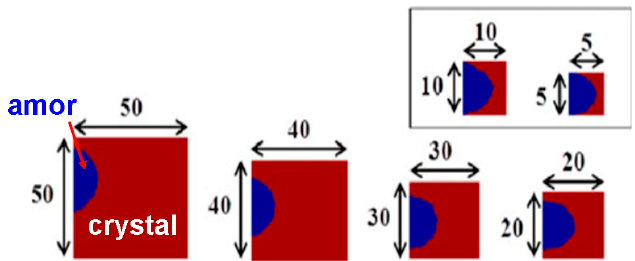
Figure 20. The resulting amorphous bits (blue region) embedded inside the surrounding crystalline background (brown red region) with respect to the thickness of the GST layer. The shape of the amorphous bit changes from a rounded shape for larger GST dimensions to ellipsoidal for smaller dimensions. Reproduced with permission from [51]. Copyright Ieee Xplore, 2017.